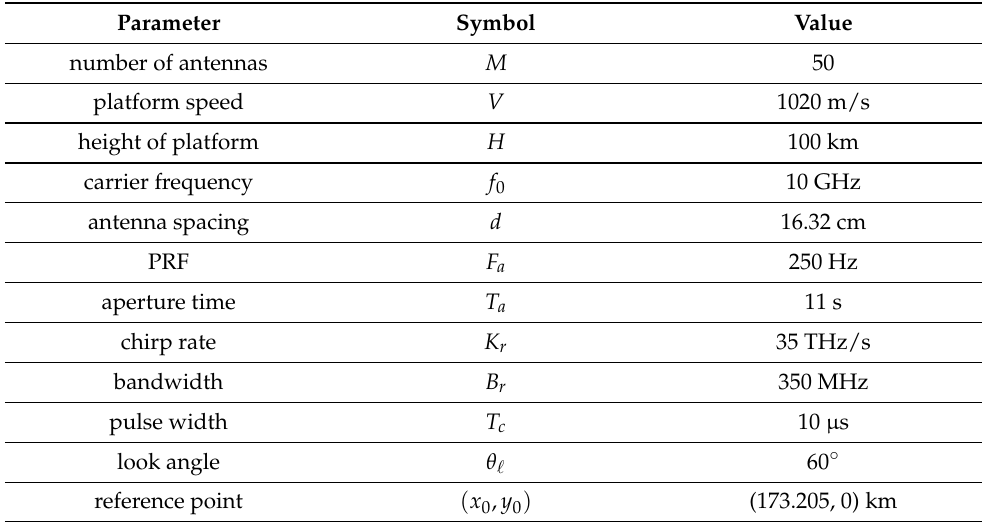
Table 1. Default parameters in